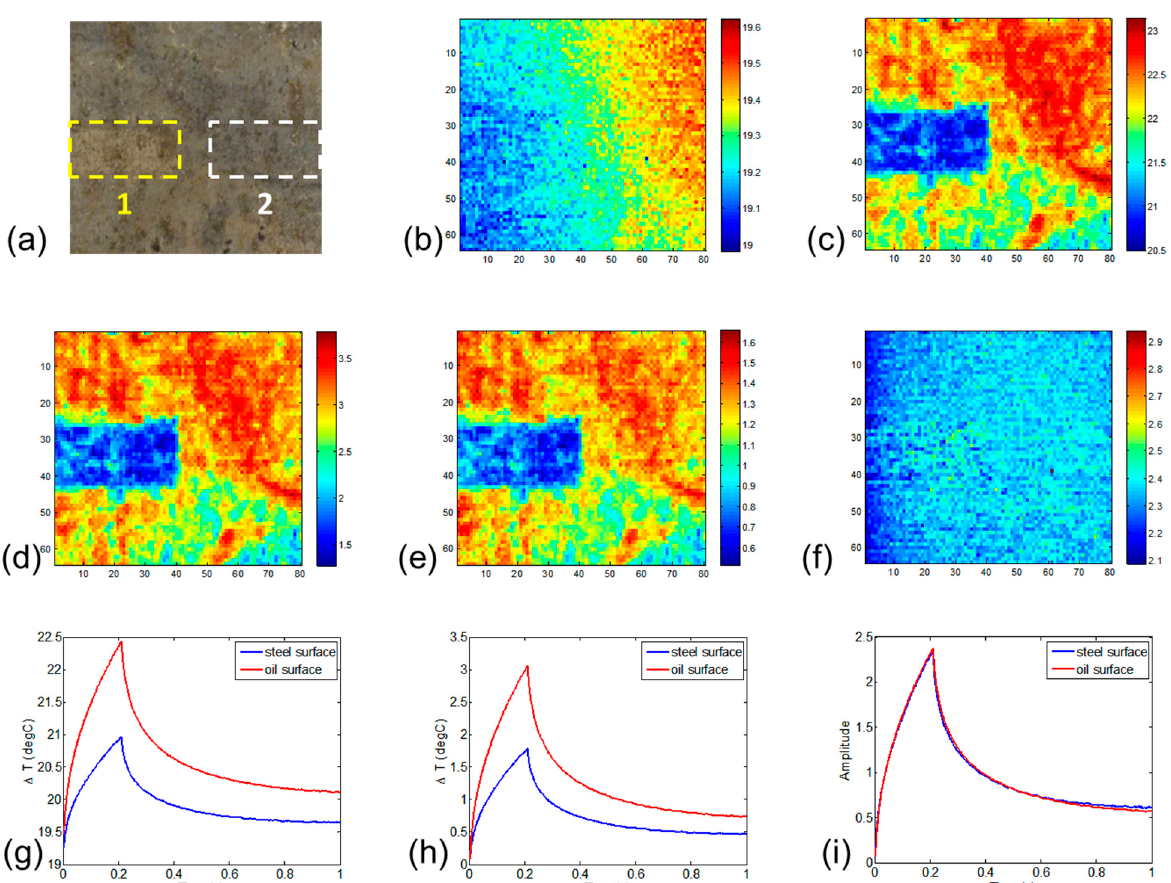
Figure 3. ( a ) Sample photograph, area 1 indicates the true surface of the steel, area 2 is the portion of the oil covered area equal in size to area 1. ( b ) Infrared image at room temperature. ( c ) Original ECPT image at maximum heating time. ( d ) Subtracted first frame. ( e ) Relative emissivity map. ( f ) Thermal pattern after emissivity correction. ( g ) Original thermal responses. ( h ) Post first frame subtraction. ( i ) Emissivity-adjusted thermal responses.